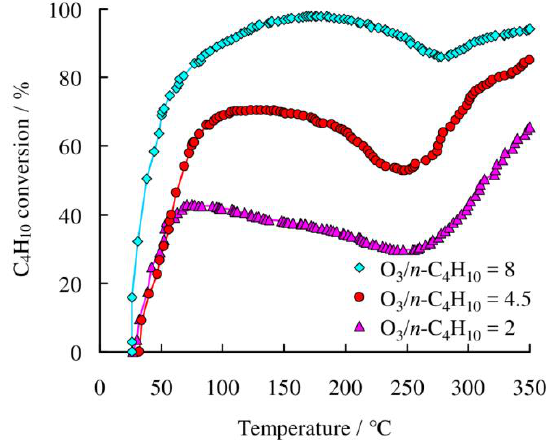
Figure 6. The OZCO of n -C 4 H 10 at different O 3 / n -C 4 H 10 ratios. Conditions: 100 ppm n -C 4 H 10 , 200 – 800 ppm O 3 , balanced with N 2 ; F total = 750 mL/min (GHSV = 155.000 h − 1 ).